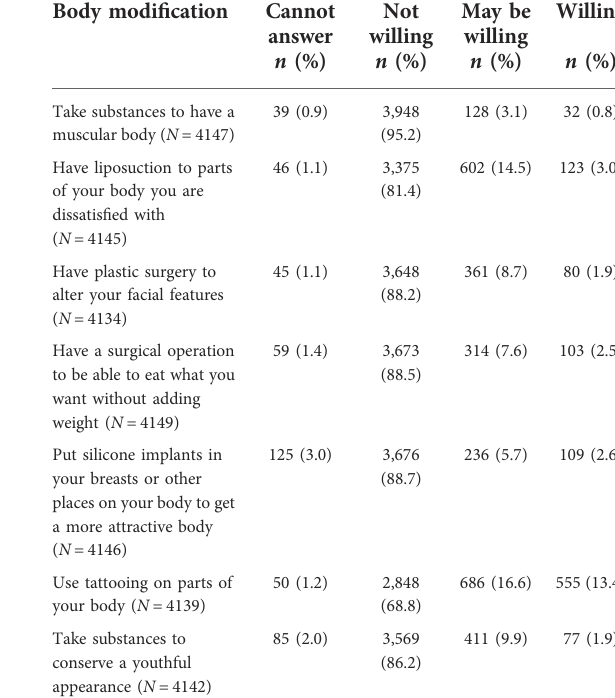
TABLE 3 Willingness towards body modi fi